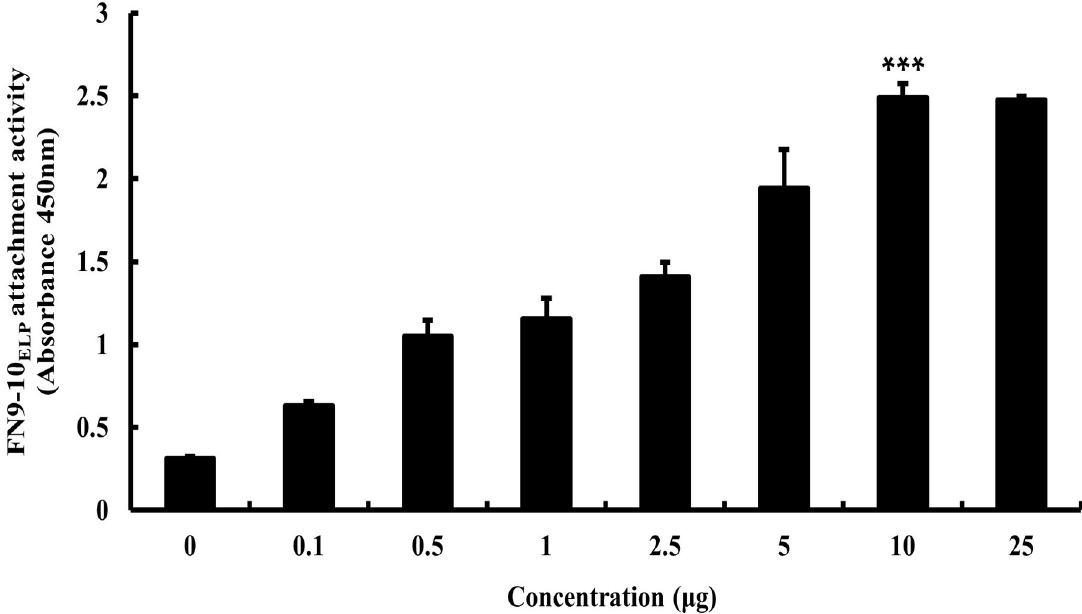
Fig 2. Protein attachment activity of FN9-10 ELP on the titanium discs. The titanium discs were immersed overnight in various concentrations of FN9-10 ELP (0 − 25 μ g) in 6-well plates at 4˚C. The absorbance of FN9-10 ELP was quantified by ELISA using a His-tag probe and reported the mean ± SD (n = 3). p <